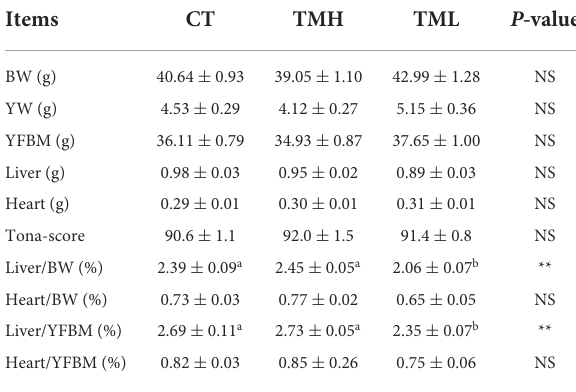
TABLE 3 Hatching performance after exposure to control or modified temperature during embryogenesis.